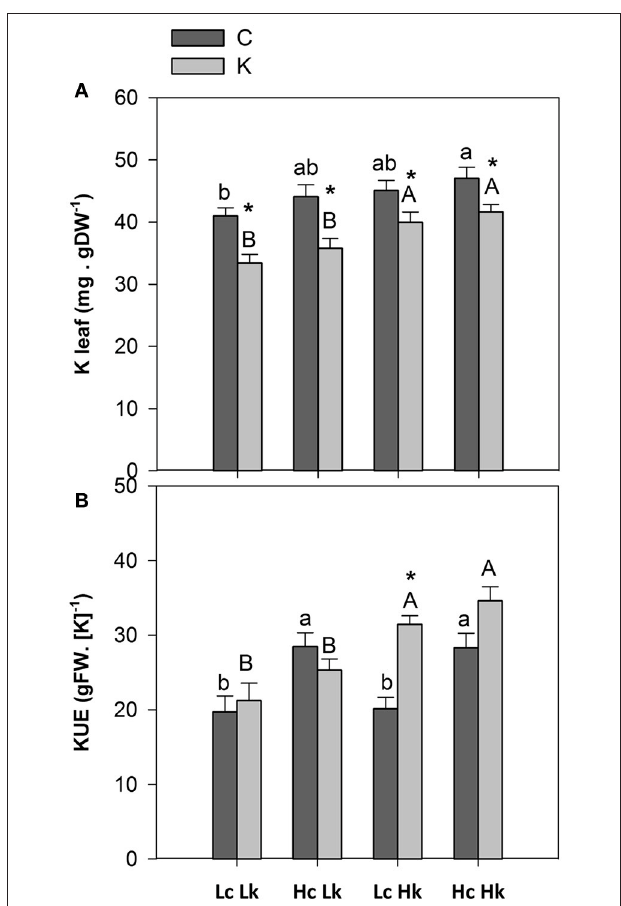
FIGURE 3 | Leaf potassium concentration (A) and potassium use efficiency (KUE, calculated as the shoot biomass generated per unit of K assimilated by a photosynthetic mature leaf) (B) of the scion ( Solanum lycopersicum cv. Boludo F1) grafted onto a population of recombinant inbred lines (RILs) from a cross between Solanum lycopersicum × Solanum pimpinellifolium with high ( H ) or low ( L ) vigor growing under control ( c ) and low K ( k ) conditions during 48 days. Different letters indicate significant differences among graft combinations ( n = 12, P < 0.05) within each treatment. * indicate significant differences between control and low-K treated plants according to the Tuckey test ( P <